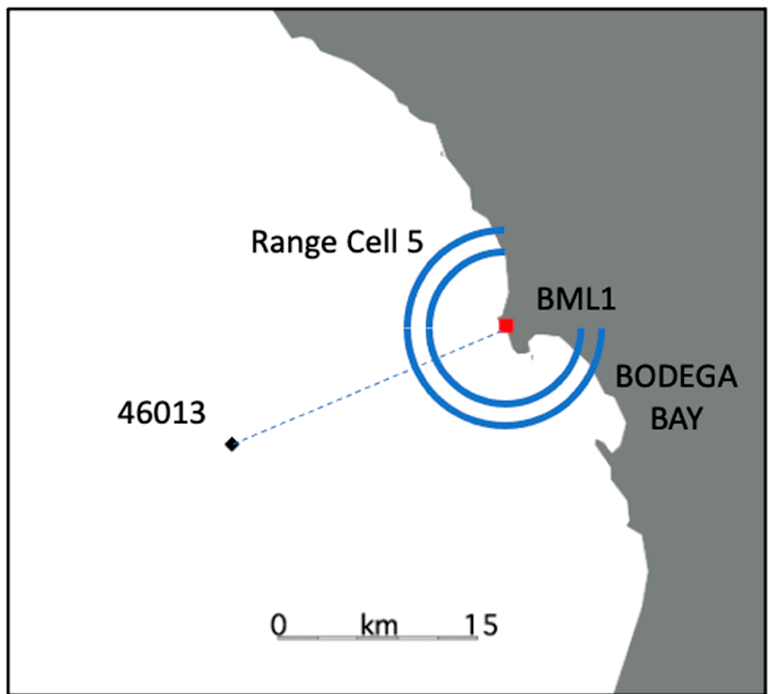
Figure 3. A map showing the locations of the SeaSonde at Bodega Bay, California (BML1) and the NOAA wave buoy 46,013. Also shown is Range-cell 5 of width 2 km: echo from Range-cell 5 was analyzed to give the following results.